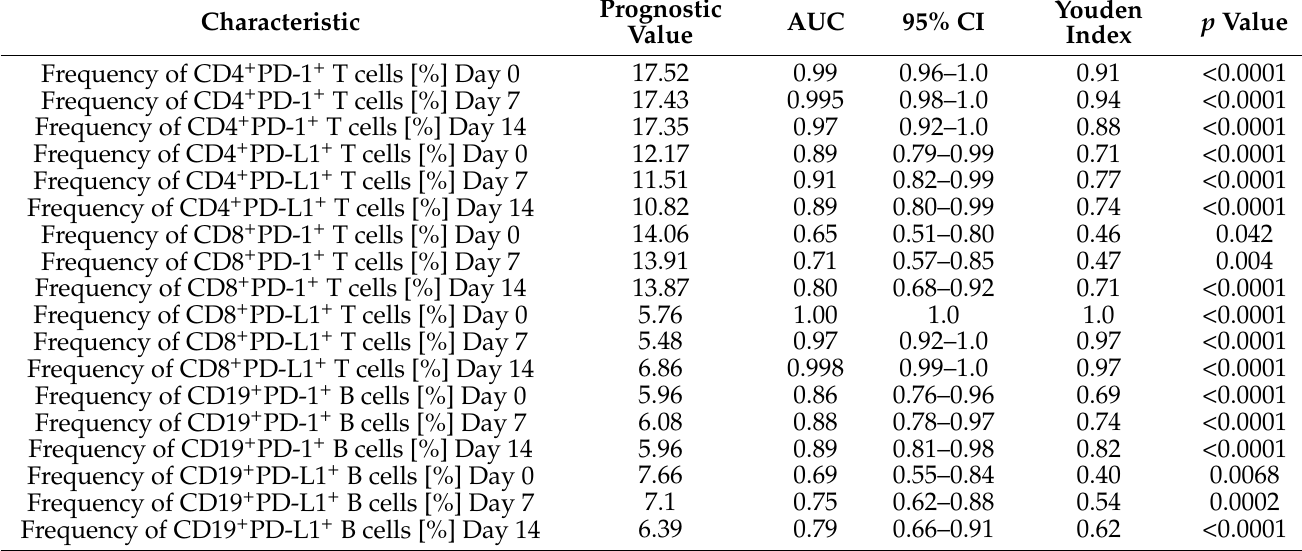
Table 4. Receiver operating characteristic (ROC) analysis of the diagnostic accuracy of lymphocyte subsets in hospitalized patients with COVID-19 (ICU versus